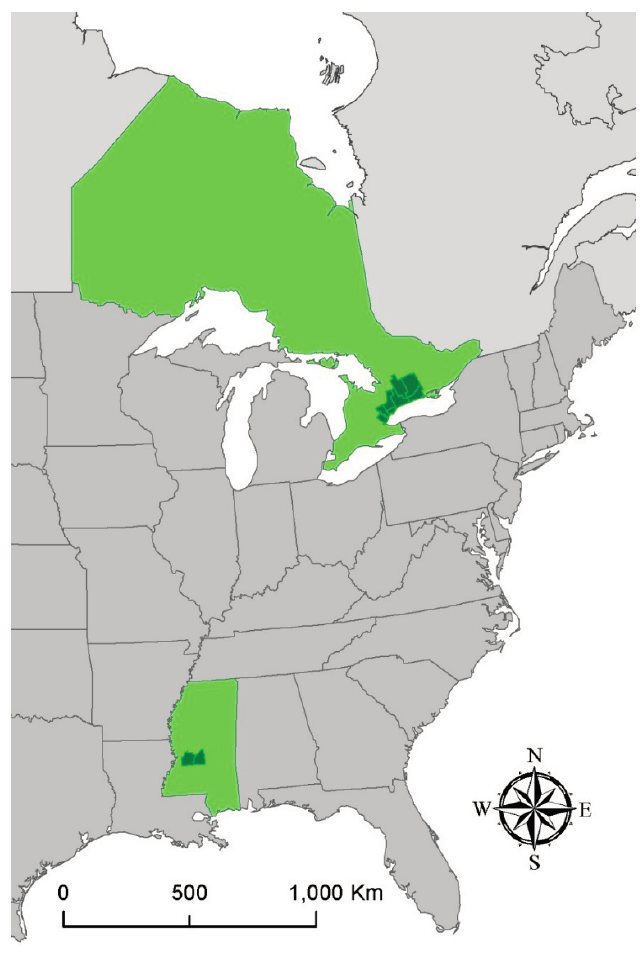
Figure 1. Study sites. Ontario and Mississippi are highlighted in light green while the Toronto and Jackson metropolitan areas are in dark